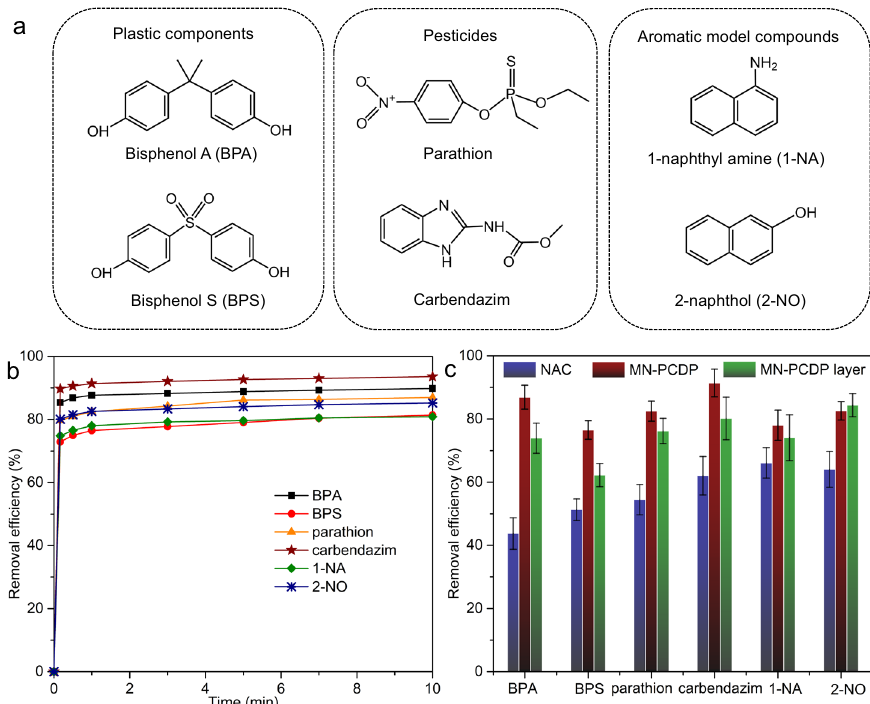
Fig. 2 MN-PCDP rapidly adsorbs a broad range of organic pollutants. a Structures of each tested organic pollutant. b Time-dependent adsorption of each pollutant (0.1 mM) by MN-PCDP (1 mg mL − 1 ). c Percentage removal ef fi ciency of each pollutant obtained by stirring NAC (blue), stirring MN-PCDP (red), and rapidly fl owing through a thin MN-PCDP layer (green). The data are reported as the average uptake of triplicate experiments. Error bars mean standard